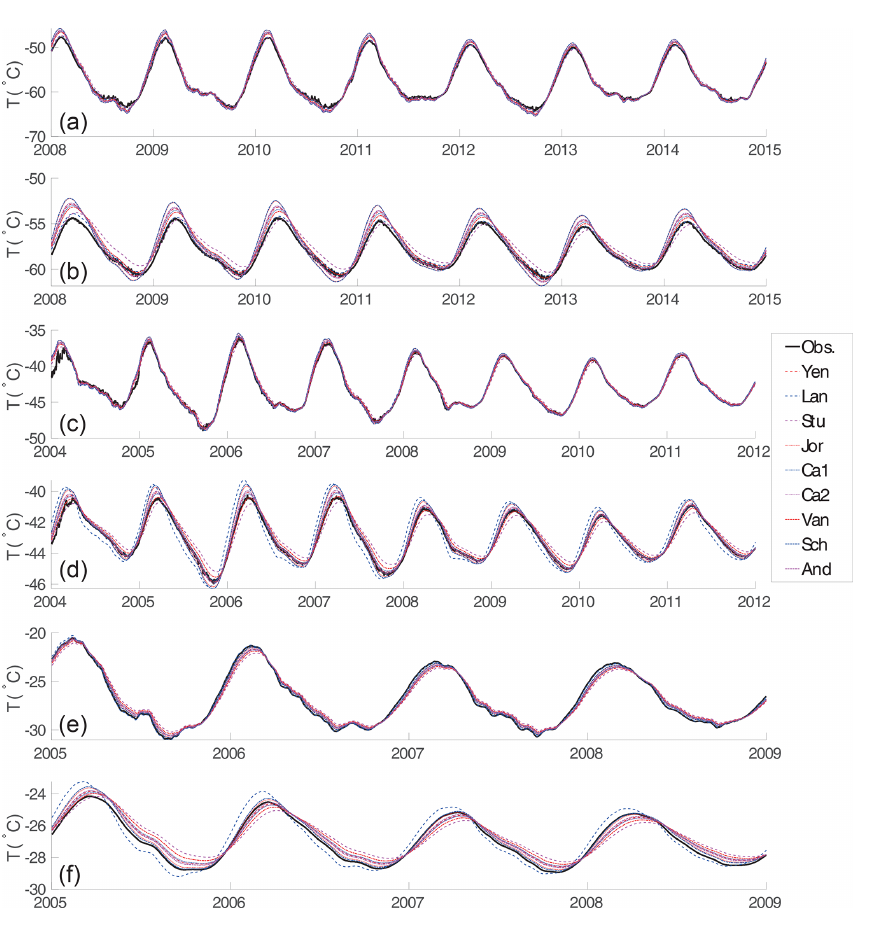
conductivity relationships. At different depth levels, differ- ent relationships appear to show varying model